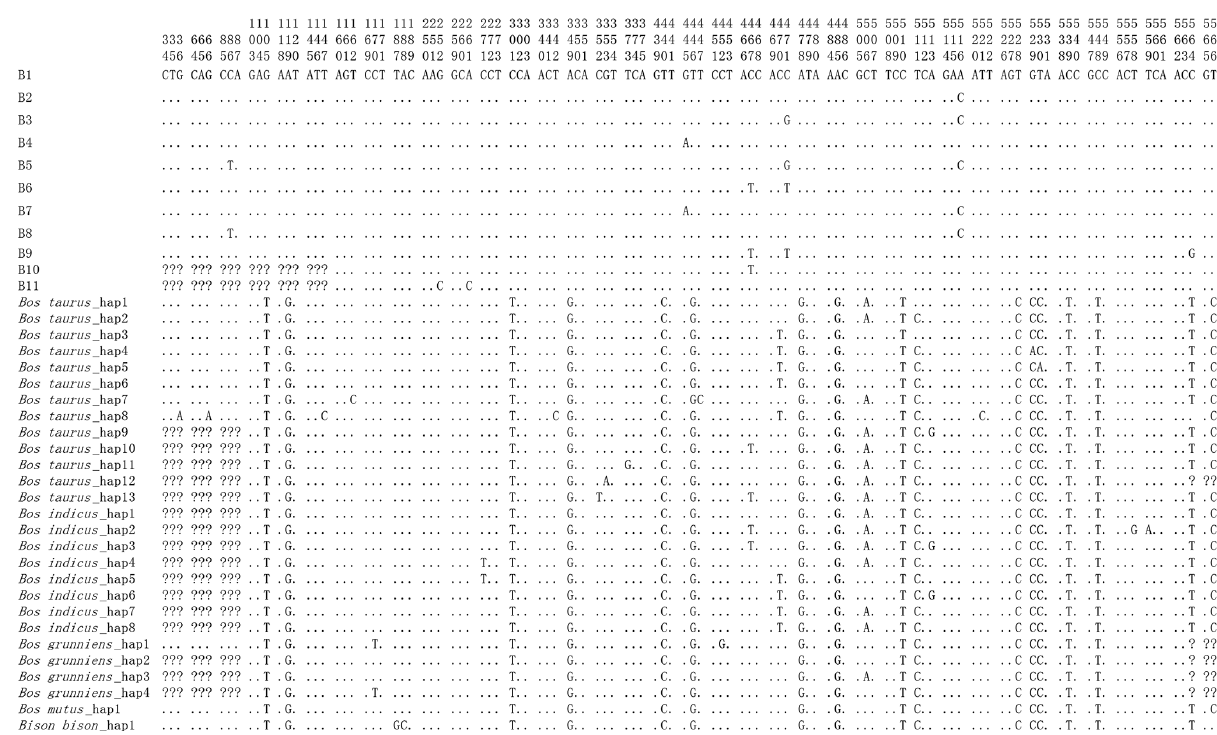
Figure 3. Nucleotide differences in the haplotype sequences between buffalo and the species of the Bos genus. Number represents the position of coding region. Dots ( · ) represents identity with B1. Nucleotide substitutions are denoted by different letters. Missing information is indicated by a question mark (?).